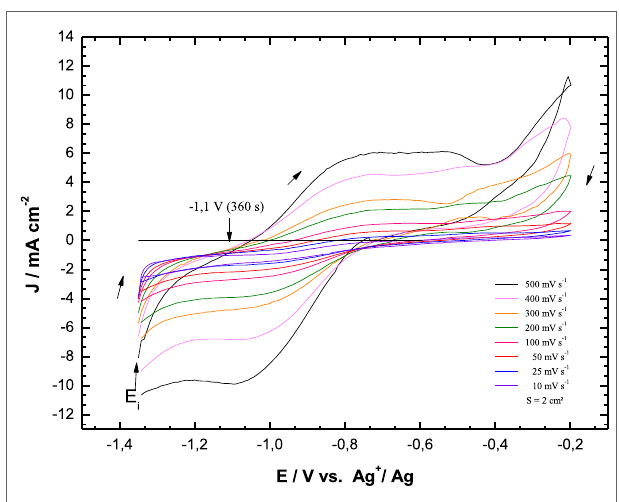
FiGURe 5 | Cyclic voltammograms of CO 2 reduction at a gold electrode in Li–Na–K at 600°C after a short pre-electrolysis of 360 s at − 1.1 v vs. Ag + /Ag under 100% CO 2 . Surface area of 2 cm 2